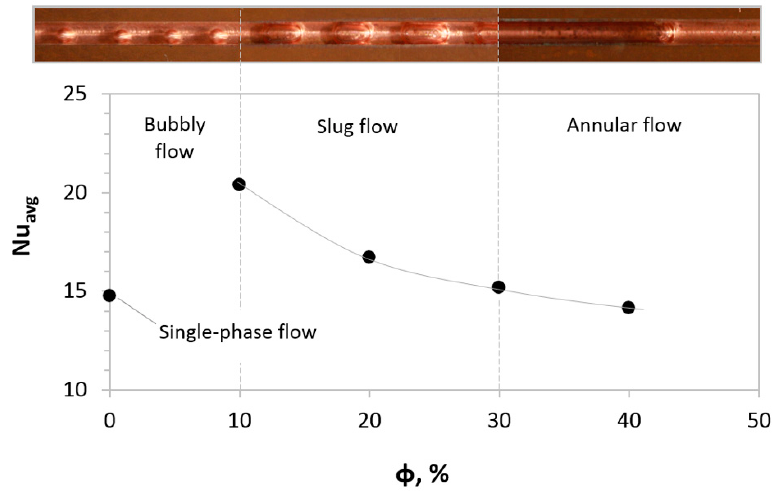
Figure 10. Dependence of the average Nusselt number on the gas hold-up at Re TP = 300. Bubbly, slug and annular flows (experimental data). Table 2. Visualization of two-phase flows at a gas content φ = 10–40%.